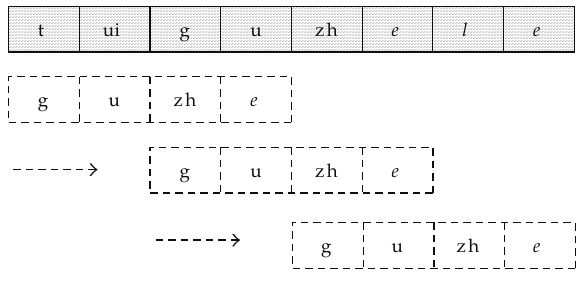
Figure 1: Extraction of “gu